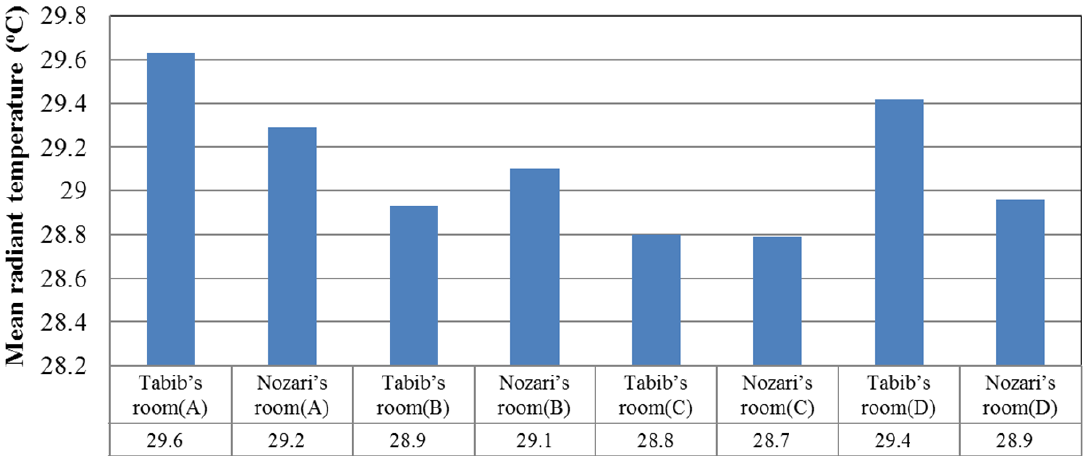
Figure 14. Average Mean Radiant Temperature (MRT) of spaces during test days (August 30 and, September 1, 4, 16, 23, 27, and 30, 2016).